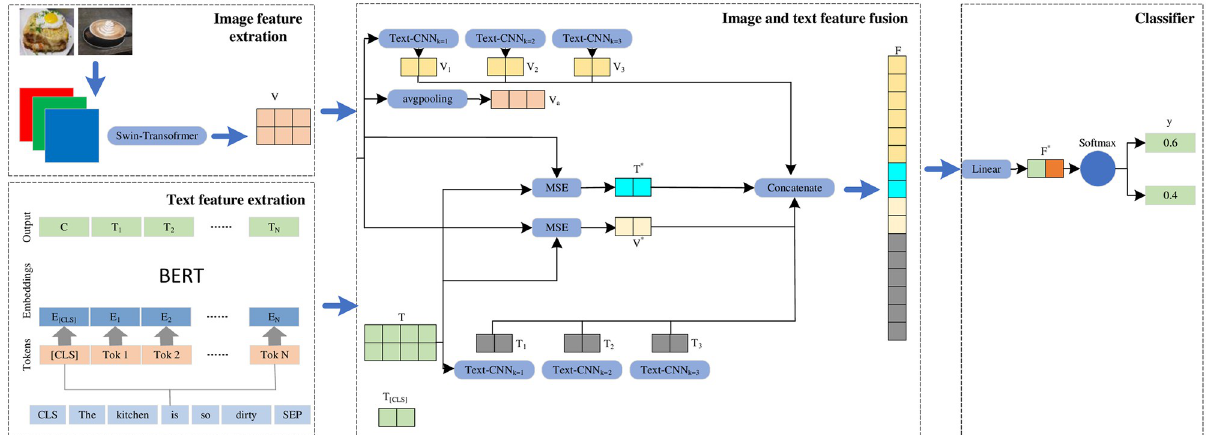
Fig 2. Multimodal false information detection method based on Text-CNN and SE